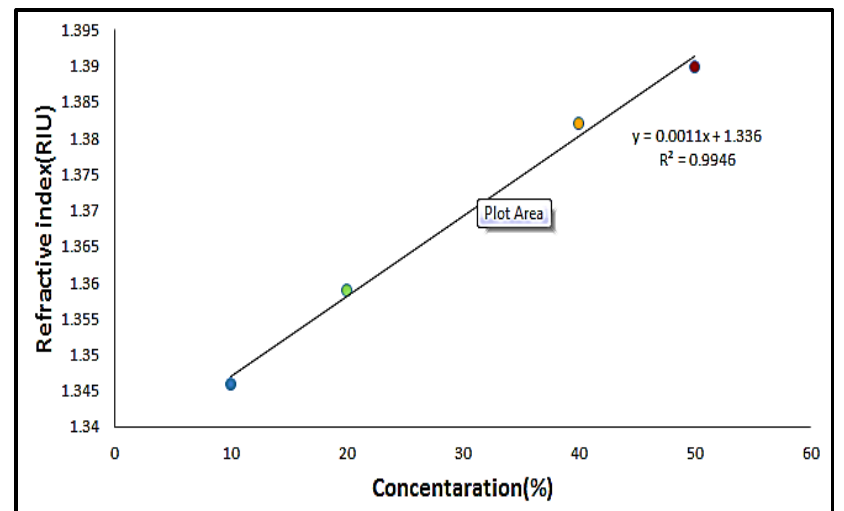
Fig.6: Refractive index of sucrose solutions as a function of the concentration of sucrose. The curve fitting is done on this figure according to equation y=0.0011x+1.336.